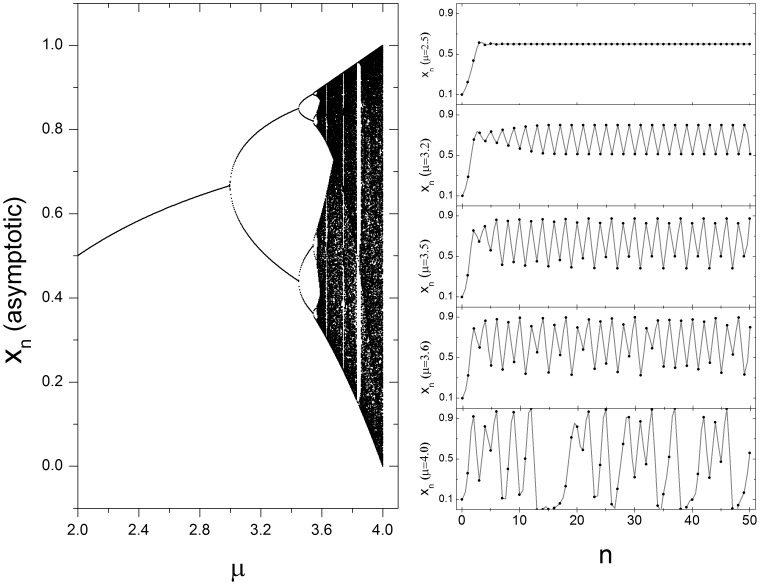
Logistic map.Left: Bifurcation diagram shoes the asymptotic value of xn as function µ. Right: Temporal evolution for five different values of µ: µ = 2.5 (stable fixed point), µ = 3.2 (period two), µ = 3.6 (chaos) and µ = 4.0 (chaos). In all cases the initial conditions were set on x0 = 0.1.